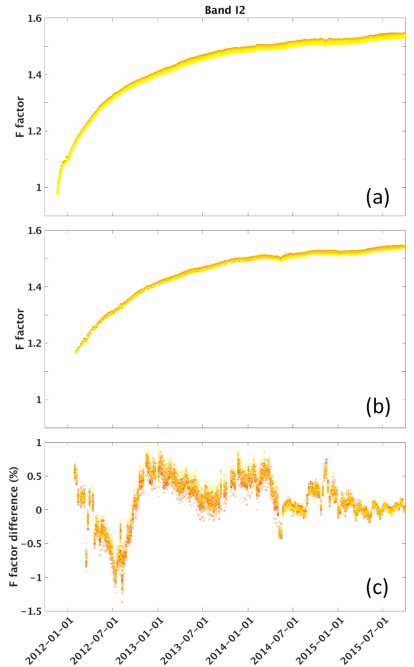
Figure A10. ( a ) VIIRS band I2 (865 nm, single gain) radiometric calibration scaling coefficients (the F factors) derived by the automated calibration procedure; ( b ) the F factors used in the operational production of the VIIRS SDR; and ( c ) relative difference between the operational F factors and the reprocessed ones (used here as a baseline). Symbol legend is the same as in Figure 4.